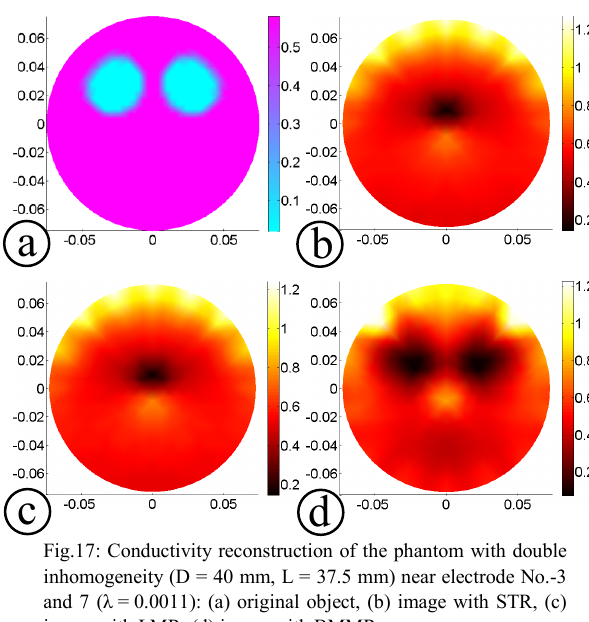
Fig .17: Conductivity reconstruction of the phantom with double inhomogeneity (D = 40 mm, L = 37.5 mm) near electrode No.-3 and 7 ( λ = 0.0011): (a) original object, (b) image with STR, (c) image with LMR, (d) image with BMMR.